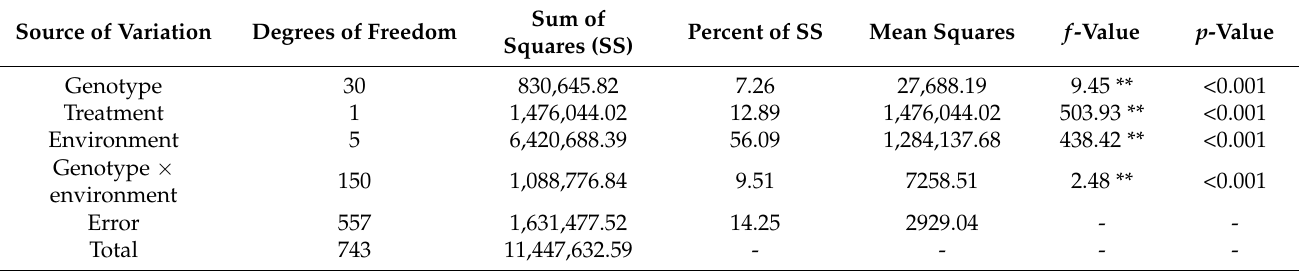
Table 2. ANOVA results for maize grain yield under two treatments at two locations in 3 years.